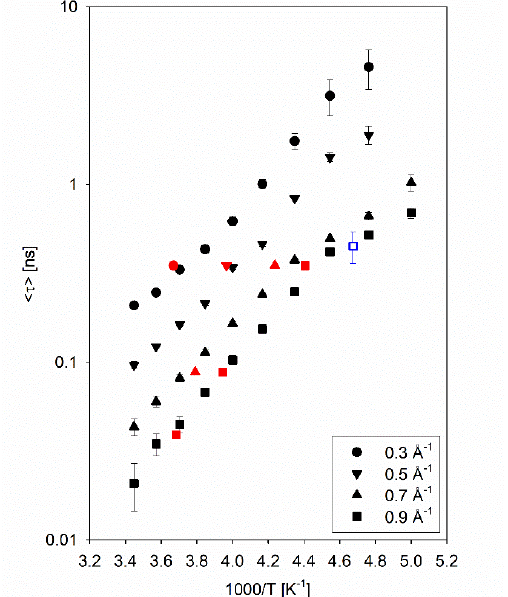
spectrometer [12] measurements: average relaxation times previously measured in the “traditional” way from QENS data [14] for (H 2 O) 0.88 (LiCl) 0.12 . Filled red symbols from neutron backscattering spectrometer [12] measurements: average relaxation times obtained from the analysis of the temperature-dependent scans as described in [13]. Open blue symbol from SNS-NSE [17] measurements: average relaxation time s obtained in the current work. For the red and blue symbols, the uncertainties in the temperature points are shown with the horizontal bars (when they exceed the size of the